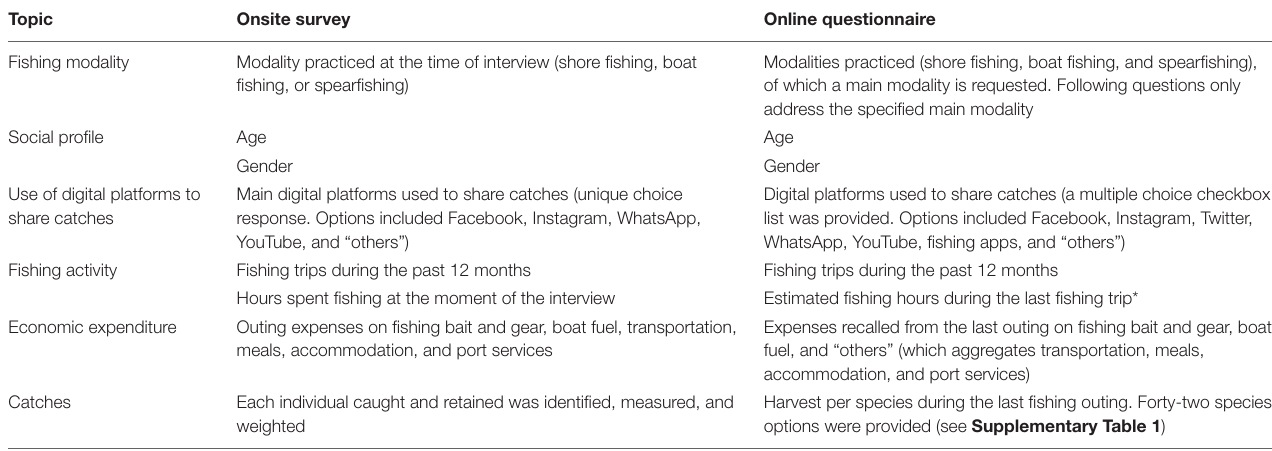
TABLE 1 | A schematic representation of the information collected during the onsite and online surveys. Topic Onsite